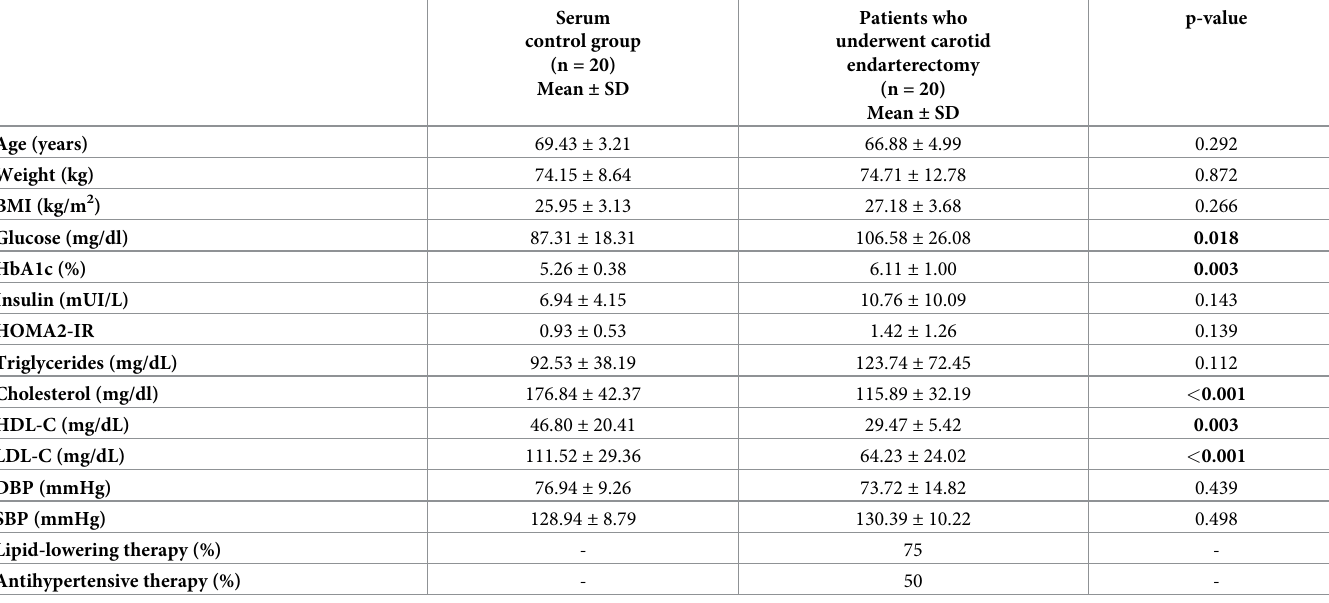
Table 1. Clinical baseline characteristics of the population studied.